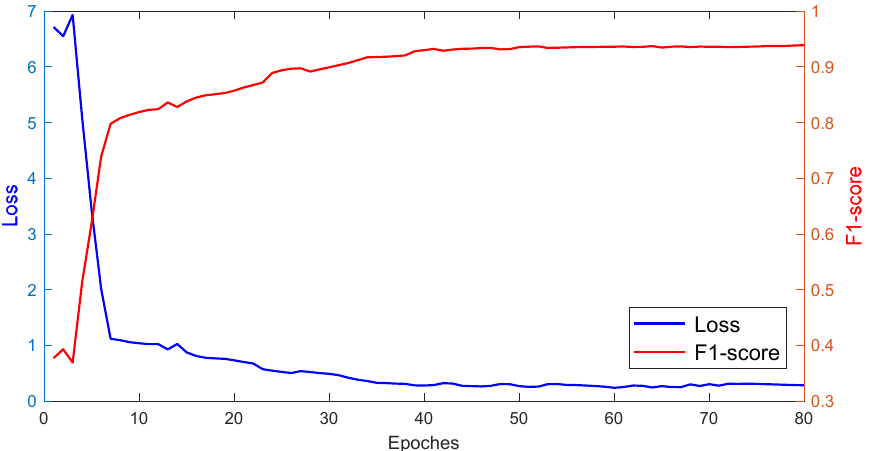
Figure 14. Loss and F1 ‐ score values at different epochs.